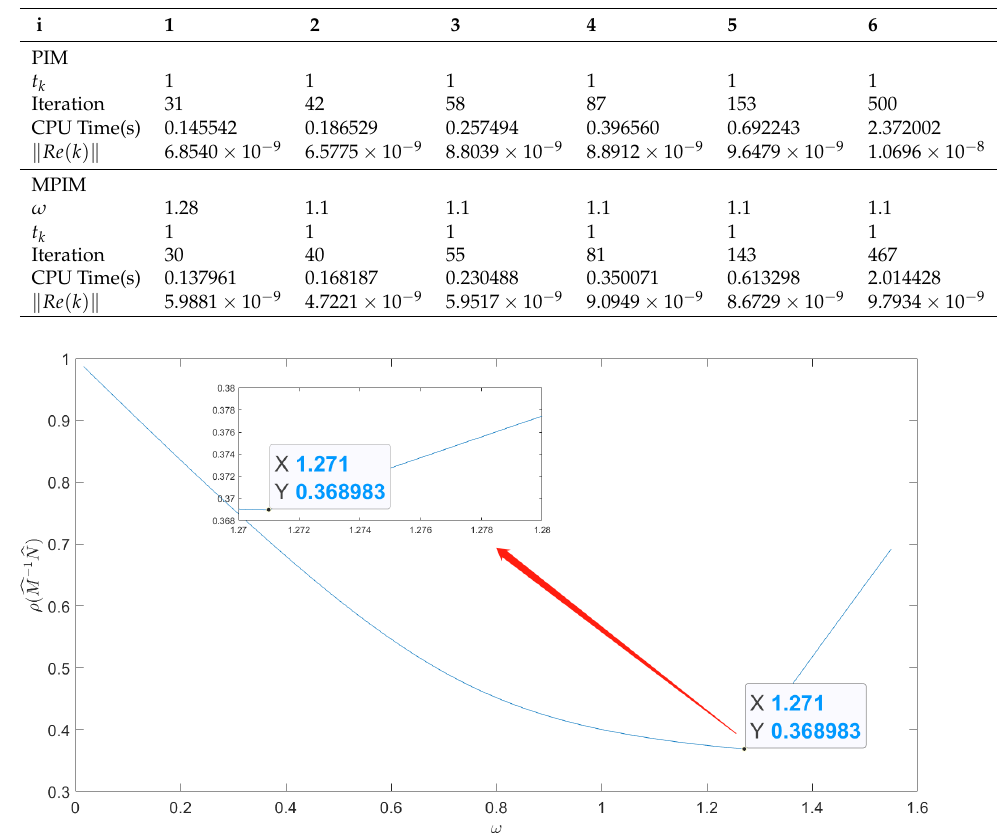
Figure 3. The spectral radius of (cid:98) M − 1 (cid:98) N for M i , i =